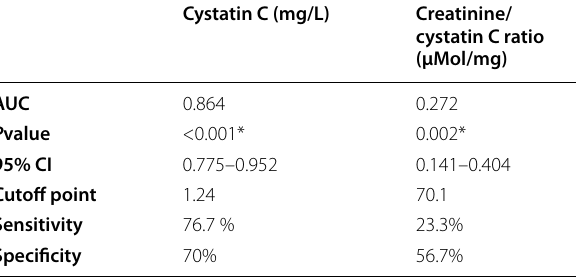
AUC area under the curve, CI confidence interval